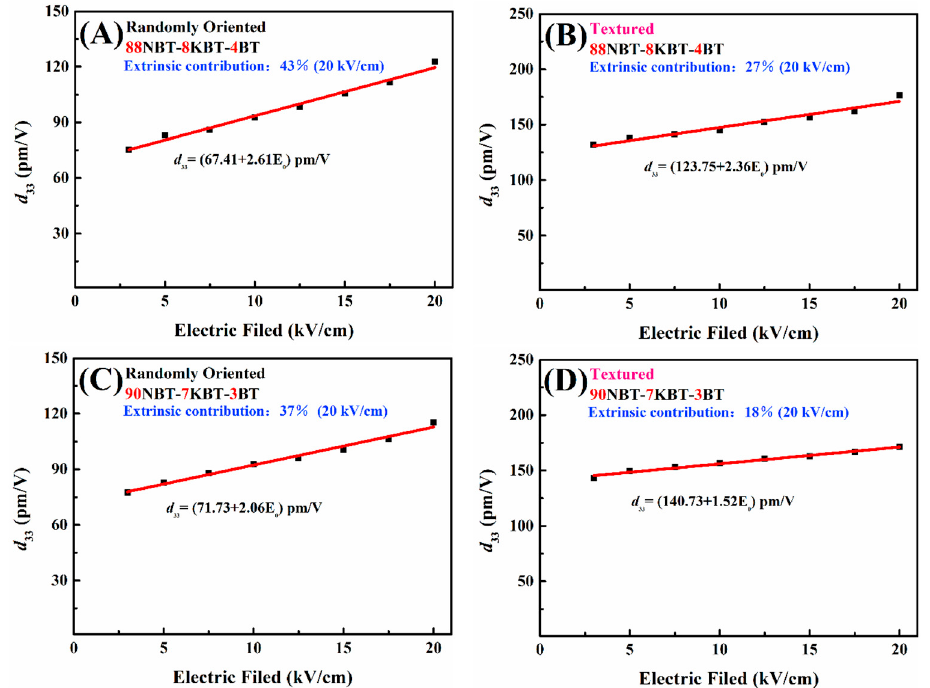
Figure 2. Temperature-dependent of dielectric constant and dielectric loss of ( A ) 88NBT randomly oriented ceramic, ( B ) 88NBT textured ceramic, ( C ) 90NBT randomly oriented ceramic, and ( D ) 90NBT textured ceramic.